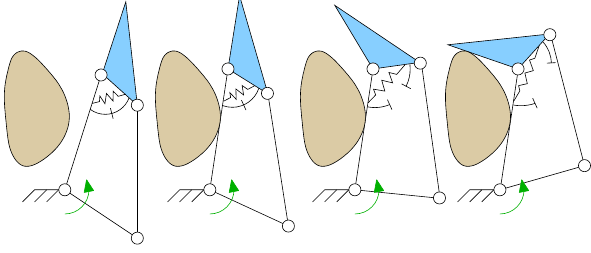
Figure 1. Closing sequence of a two-DOF self-adaptive finger.